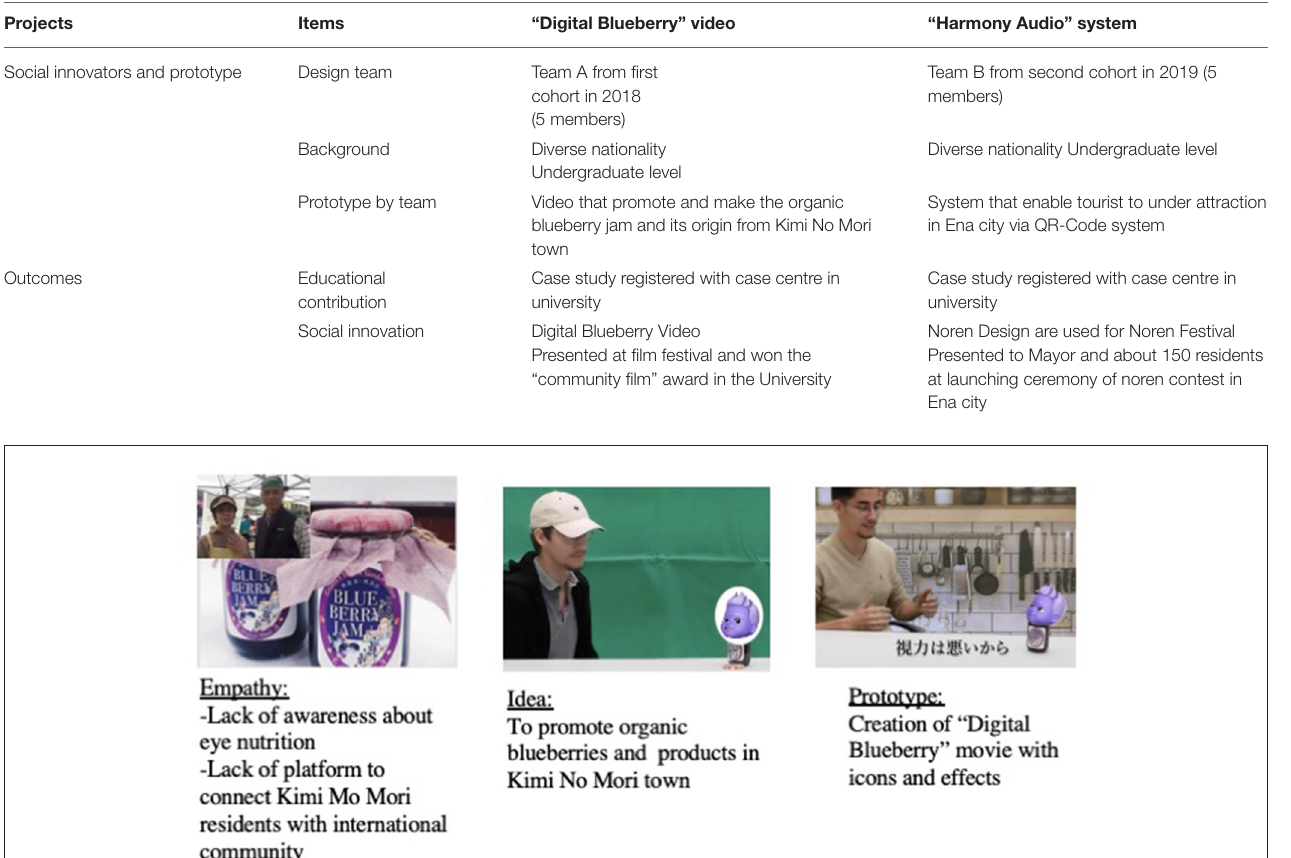
users would obtain information about Ena’s main